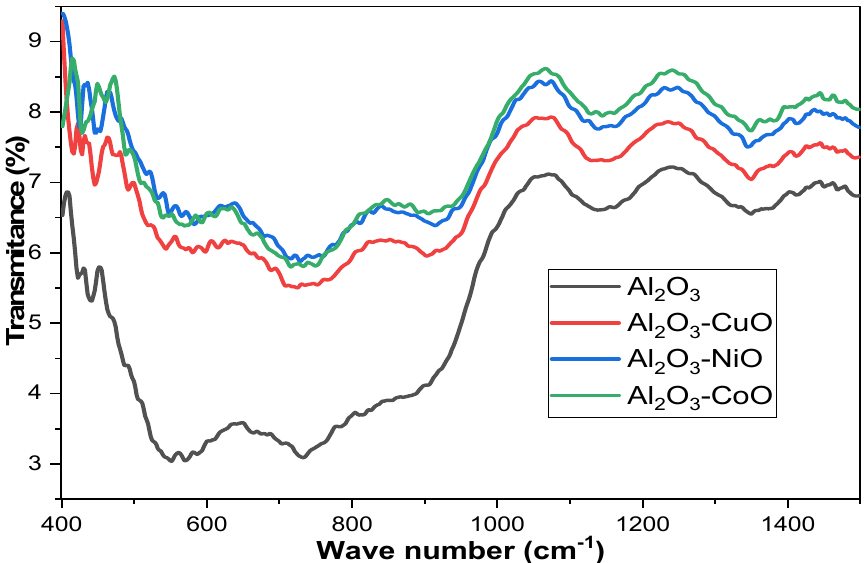
Figure 5. FTIR findings for the Al 2 O 3 nanoparticle and its CuO, NiO, and CoO nanocomposites.